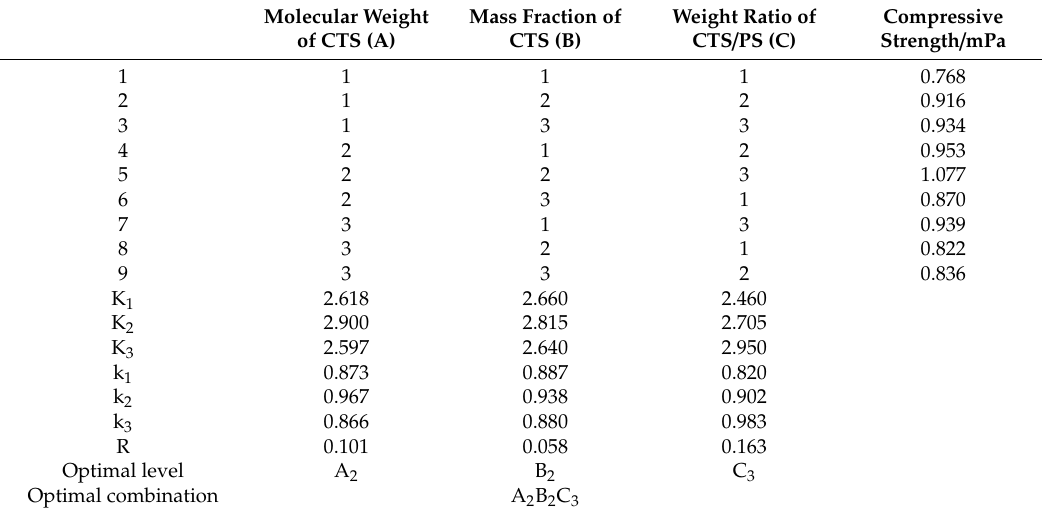
Table 6. Design and results of orthogonal test.